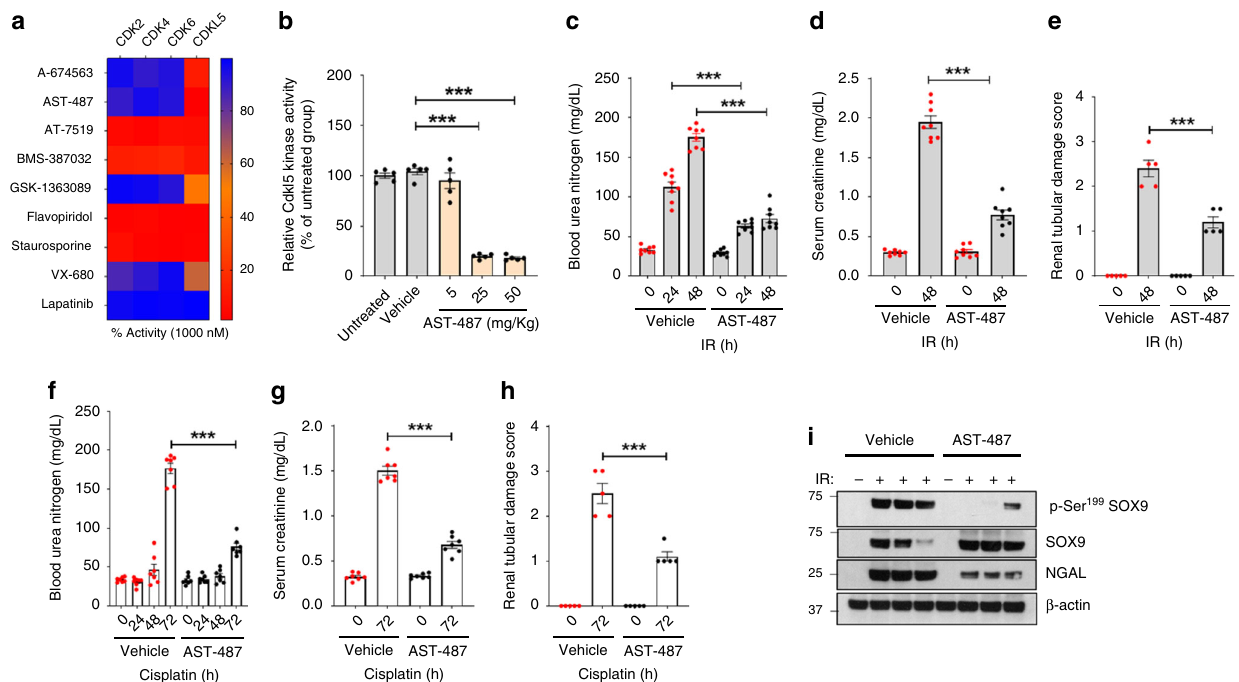
Fig. 6 A small-molecule Cdkl5 inhibitor mitigates AKI. a In vitro kinase assays were carried out for cell-cycle-related kinases and CDKL5 for the indicated inhibitors at a single concentration of 1 µ M. Kinase activity is presented as a heat map, where blue indicates no inhibition (high kinase activity), while red indicates kinase inhibition (low kinase activity). AST-487 was found to inhibit CDKL5, without affecting the activity of cell-cycle-related kinases. Data presented here are the mean of three independent experiments. b C57BL/6 mice were treated with either vehicle or AST-487 through oral administration followed by examination of Cdkl5 activity in renal tissues. Data are presented as individual data points ( n = 5 biologically independent samples), from one out of two independent experiments, all producing similar results. c – e Bilateral renal ischemia was induced in wild-type C57BL/6 mice for 30 min followed by reperfusion for indicated timepoints. Mice were treated with either vehicle or AST-487 (25 mg/kg, oral gavage) 6 h post ischemia, followed by assessment of renal function and damage. c Blood urea nitrogen, d serum creatinine, and e renal histological analysis (H&E), Data presented ( c – e ) are cumulative of three independent experiments ( n = 8). f – h Wild-type C57BL/6 mice were injected with cisplatin (30 mg/kg, i.p.) followed by treatment with either vehicle or AST-487 (25 mg/kg, oral gavage) 6 h later, followed by assessment of renal function and damage at indicated timepoints. Data presented ( e – h ) are cumulative of two out of four independent experiments ( n = 8) that showed similar results. i Western blot analysis of renal tissues indicated that AST-487 suppresses Sox9 phosphorylation and increases Sox9 stability in vivo. Blots are representative of three independent experiments. In all the bar graphs, experimental values are presented as mean ± s.e.m. The height of error bar = 1 s.e. and p < 0.05 was indicated as statistically signi fi cant. One-way ANOVA followed by Dunnett ’ s ( b ) or Tukey ’ s multiple-comparison test ( c – h ) was carried out, and statistical signi fi cance is